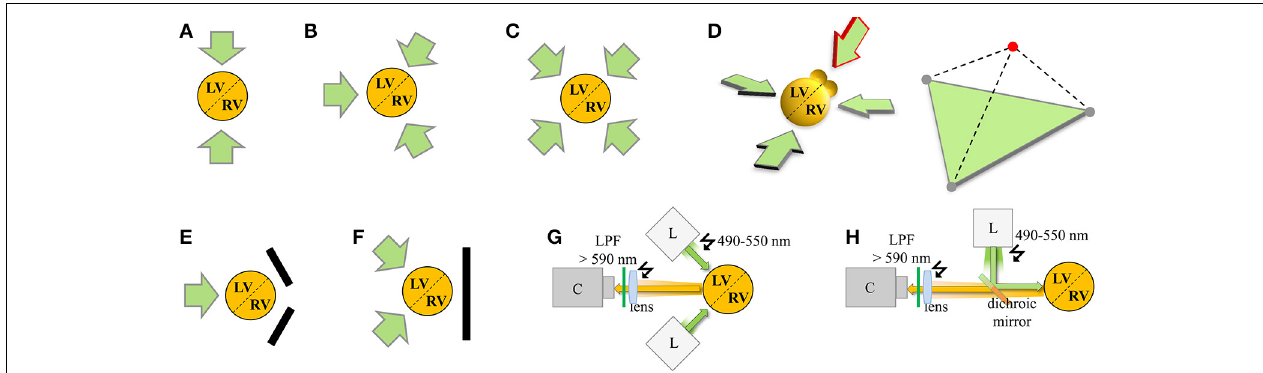
FIGURE 2 | Schematic summary of VSDI configurations for panoramic cardiac imaging. The orange circle represents the total emitted red-shifted fluorescence voltage signal emanating from the cardiac 3D object comprised of the left (LV) and right (RV) ventricles, and anatomically delimited by epicardial/septal blood vessels (dashed line). Each green arrow represents an individual VSDI camera configuration. Specific configurations of panoramic multi-camera setups assuming a central heart axis of interest are indicated as shown (for associated excitation light configurations please refer to G,H ). (A) 2-camera configuration for pig heart recording according to Chattipakorn et al. (2001); (B) 3-camera configuration for rabbit hearts according to Qu et al. (2007), Evertson et al. (2008); (C) 4-camera configuration for pig hearts according to Kay and Rogers (2006). (D) Theoretical 3D extension based on the camera configuration in (B) with 3 in-plane cameras imaging the ventricles and 1 out-of-plane camera imaging the atria (red arrow). The 3D camera configuration is summarized in the right tetrahedron by 3 gray circles